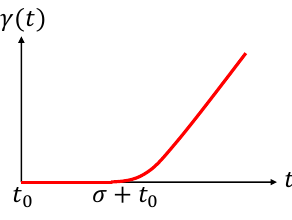
Figure 6. An illustrative example of the uncertainty level γ ( t ) .